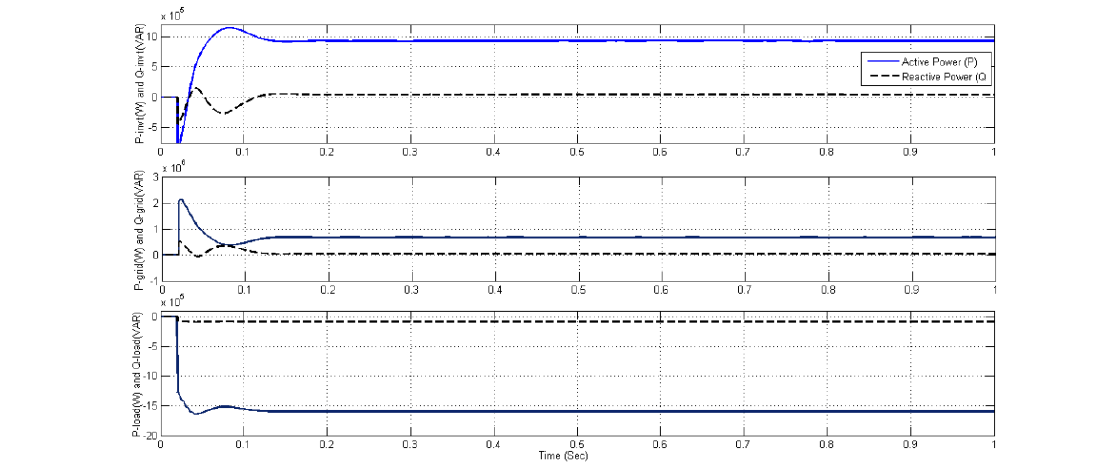
Figure 9 : Power flow curves when